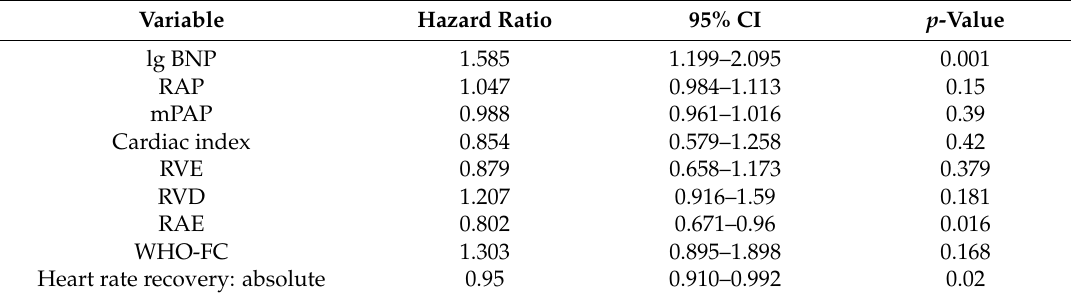
Table 4. Multivariate analysis of predictors of mortality in study